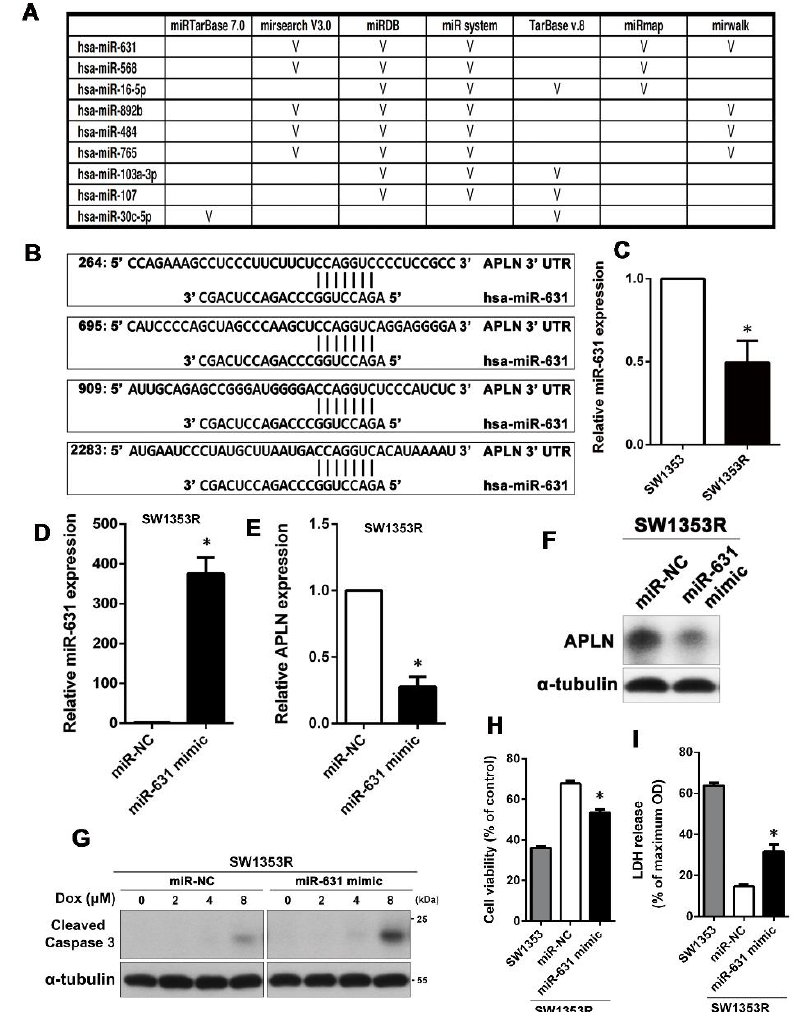
Figure 3. High expression of miR-631 can downregulate APLN protein levels to increase Dox sensitivity in SW1353R cells. ( A ) Seven different databases were combined to find microRNAs targeting APLN. ( B ) A possible miR-631 target region was found in the 3’ UTR of APLN mRNA. ( C ) The expression of miR-631 in SW1353 and SW1353R cells was analyzed using qPCR. * p < 0.05 compared with SW1353 cells. ( D , E ) SW1353R cells were transfected with miR-631 mimic or miR-NC and the expression levels of miR-631 and APLN were determined by qPCR. * p < 0.05 compared with miR-NC group. ( F ) After SW1353R cells were transfected with miR-631 mimic, the protein expression of APLN was analyzed by Western blot. ( G ) Cells were then stimulated with different concentrations of Dox (0–8 µ M) for 24 h, and the cell viability was determined by MTT. ( H , I ) The effect of miR-631 on Dox sensitivity was also analyzed by MTT and LDH analyses. MiR-631-transfected SW1353R cells and their parental cells (SW1353 cells) were treated with 8 µ M Dox for 24 h. * p < 0.05 compared with miR-NC